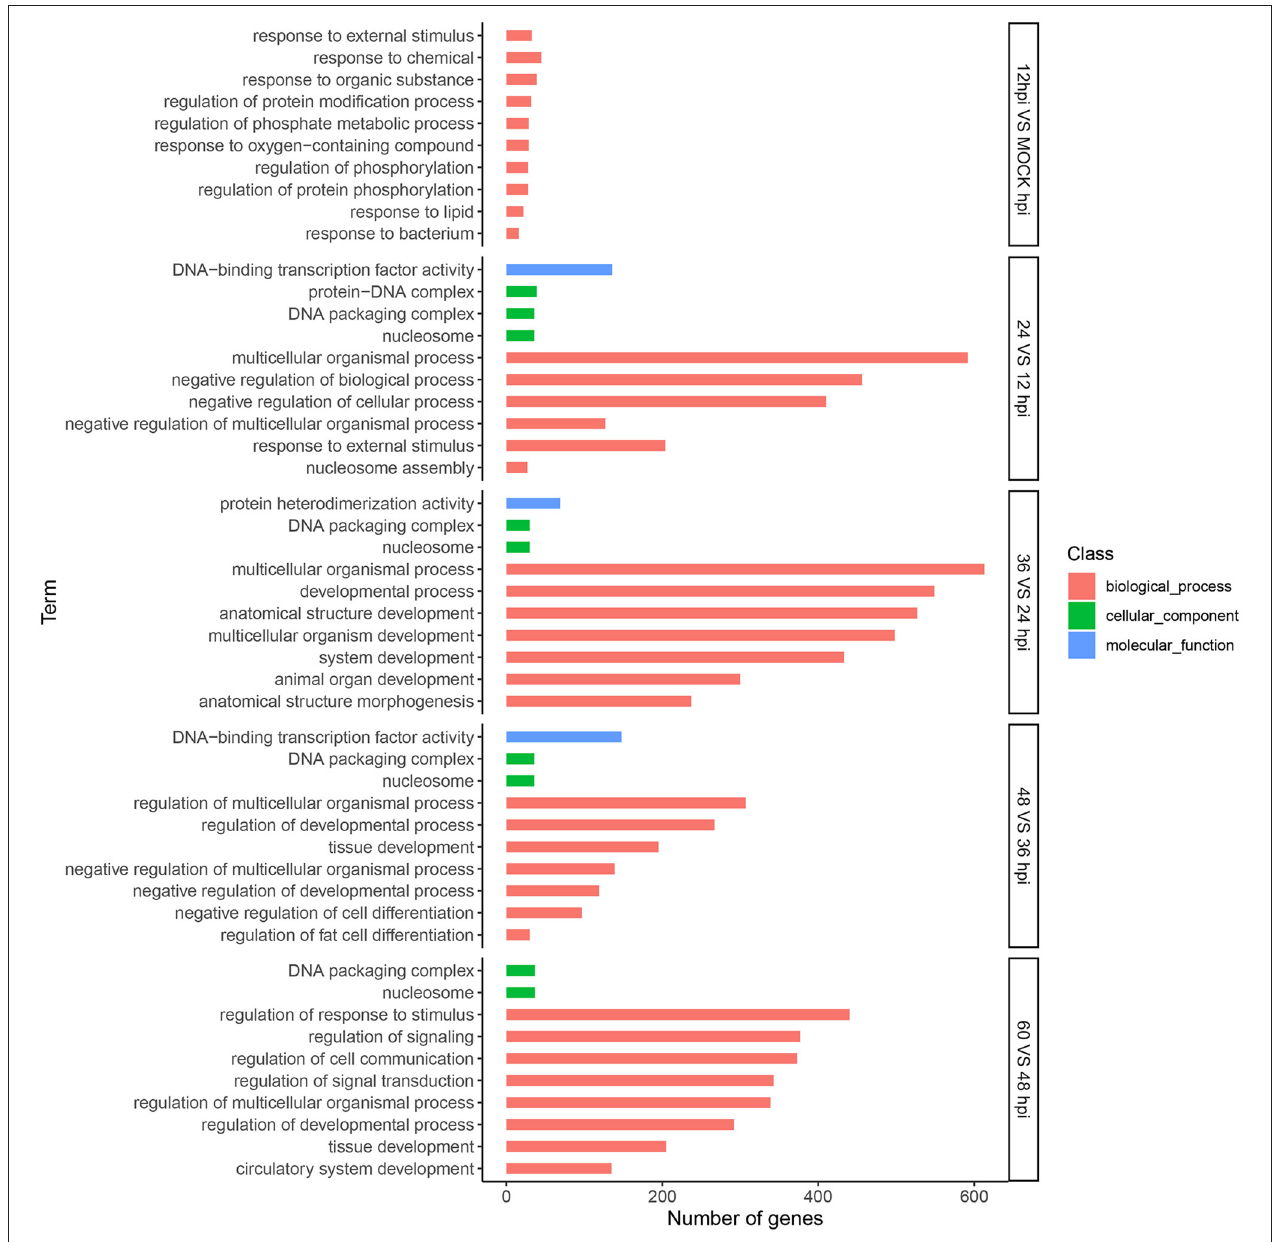
FIGURE 3 | Analysis of DEGs using Gene Ontology (GO) terms. Top 10 GO categories significantly ( P -value < 0.05) enriched in biological processes at five time points. The x-axis represents the number of genes, and the y-axis represents functional groups.